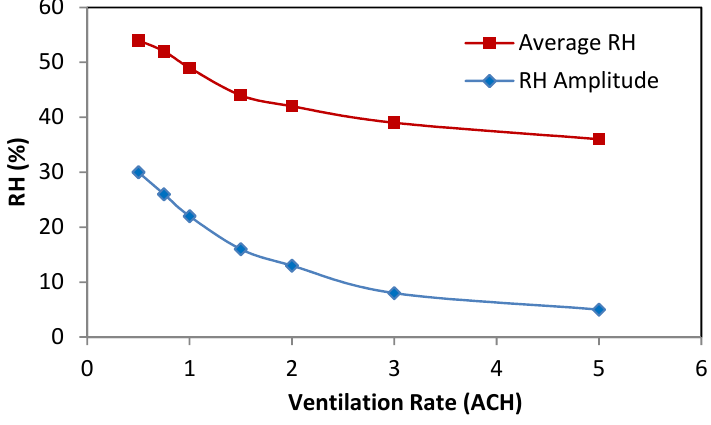
Figure 5. Relation between ventilation rate and room relative humidity for uncoated gypsum board and wood paneling under supply air humidity at 4.7 g/kg (cases 1, 22, 25–34).